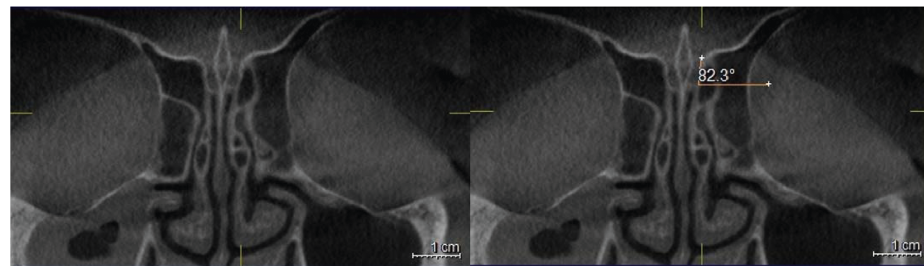
Figure 4: Coronal plan of CBCT demonstrating type I Gera classification on the left